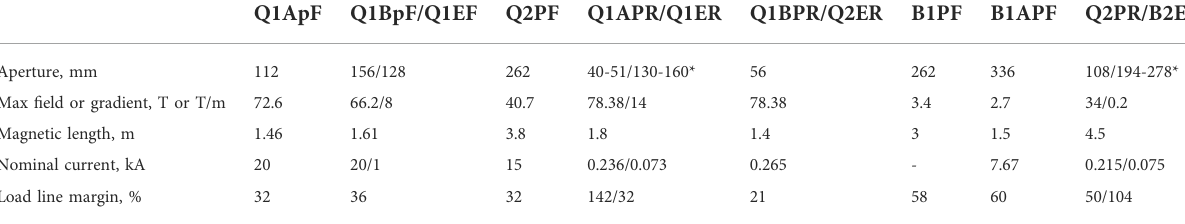
TABLE 2 IR1 Nb-Ti magnet